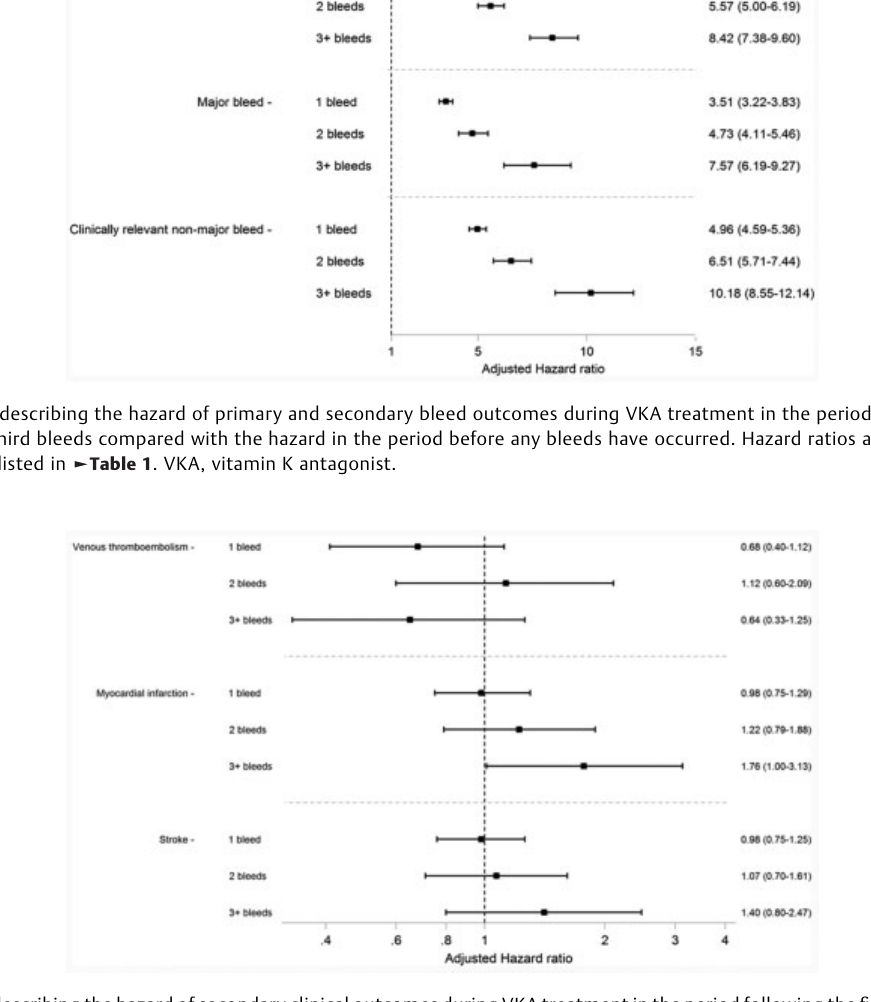
TH Open Vol. 3 No.